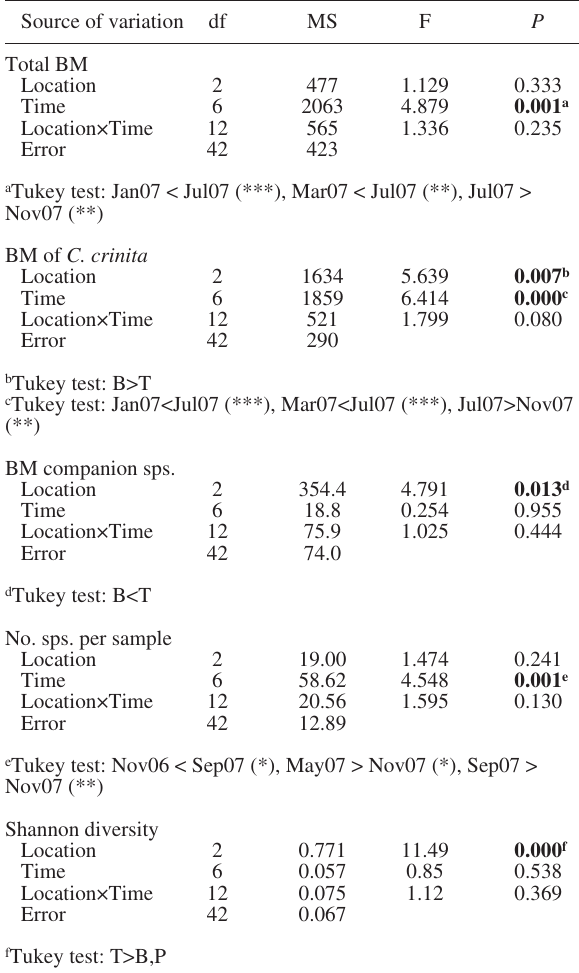
Table 3. – Results of two-way ANOVA tests for determining dif- ferences in total biomass, biomass of C. crinita , biomass of compan- ion species, number of species per sample, and Shannon diversity, among locations and sampling times. Bold : significant P values;